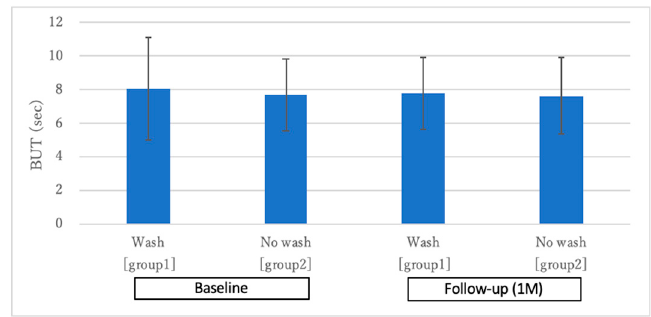
Figure 2. Changes in tear film breakup time (TBUT). Note the nonsignificant TBUT changes between before and after 1 month of eyewash use ( p > 0.05).